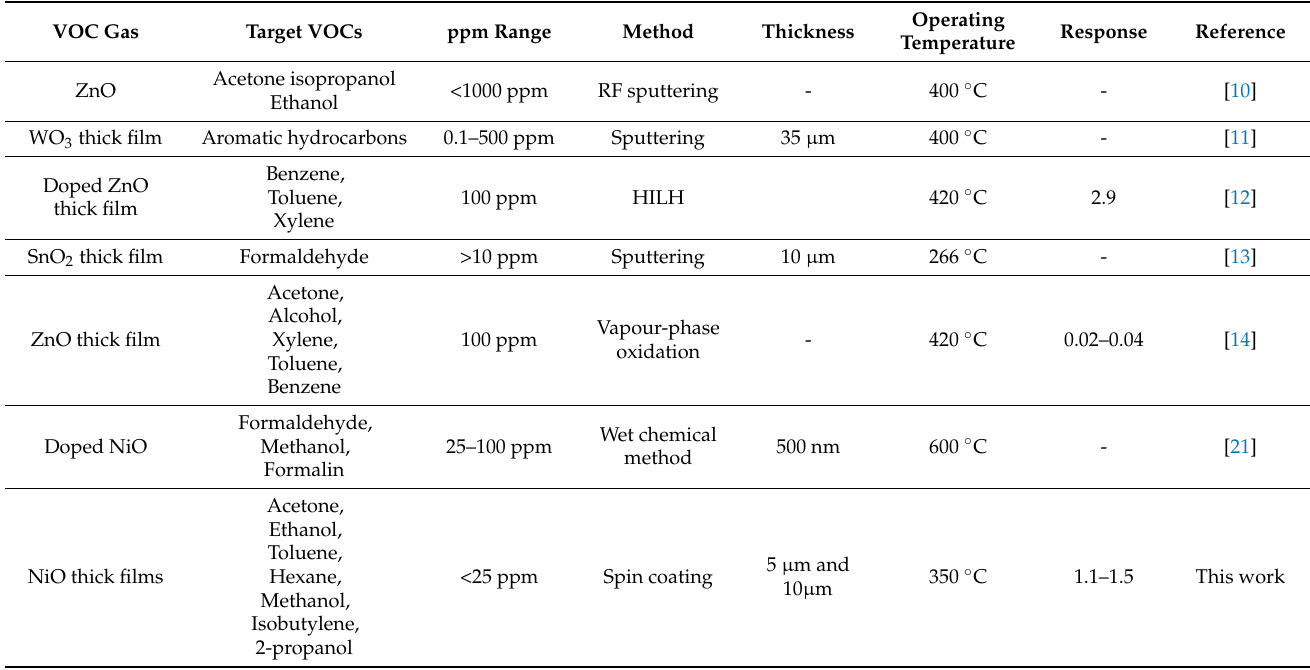
Figure 7. Baseline resistance and sensor response at 40% r.h. and at 90% r.h. conditions of ( a ) S-10 sensor and ( b ) S-5 sensor. Relative response (R g /R a ) at 40% r.h. and at 90% r.h. conditions of ( c ) S-10 sensor and ( d ) S-5 sensor. Table 2. Comparison table of MOX devices for VOCs versus this